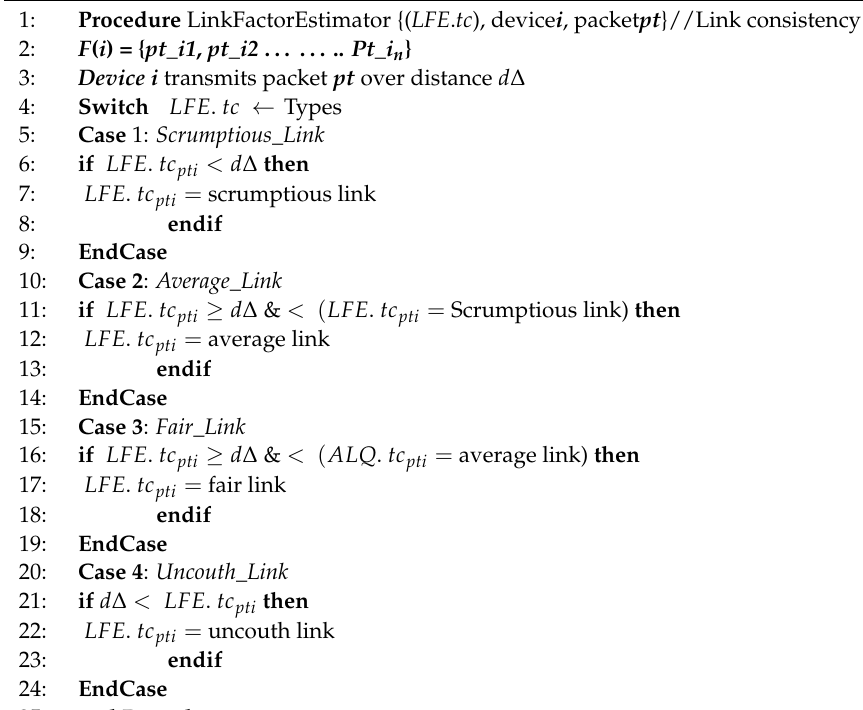
Algorithm 1 Link consistency estimation and packet forwarding